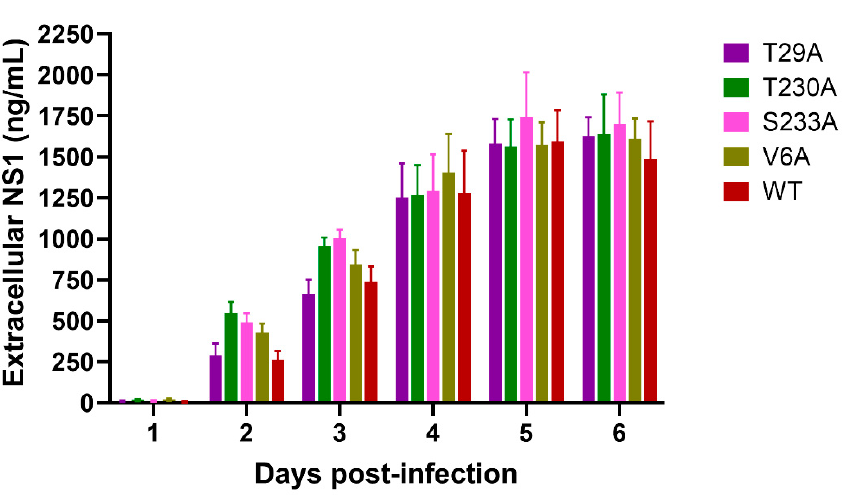
Figure 5. Effects of phosphorylation site mutations of DENV NS1 on secretion of DENV NS1 protein. Culture supernatants were collected from Vero cells infected with wild-type DENV or different virus mutants at the indicated time points post-infection and assayed for the levels of extracellular NS1 protein by NS1 ELISA. The results show the mean ± SEM of four independent experiments.